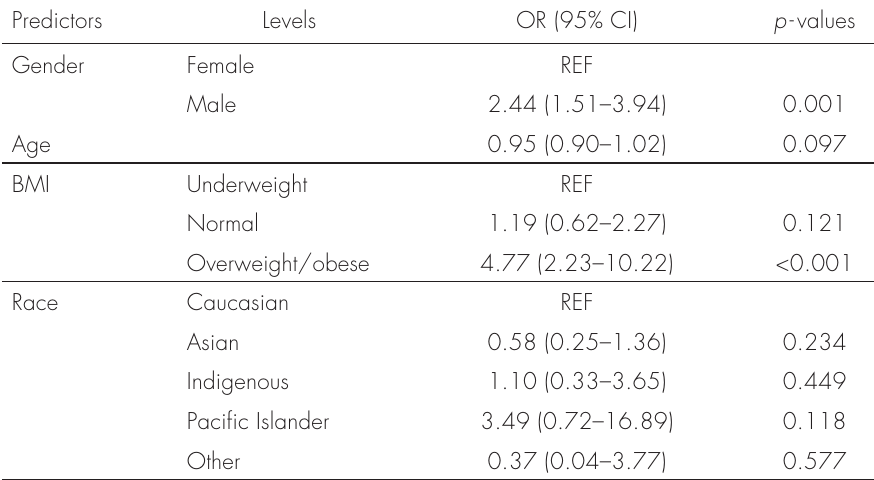
Table VII. Logistic regression